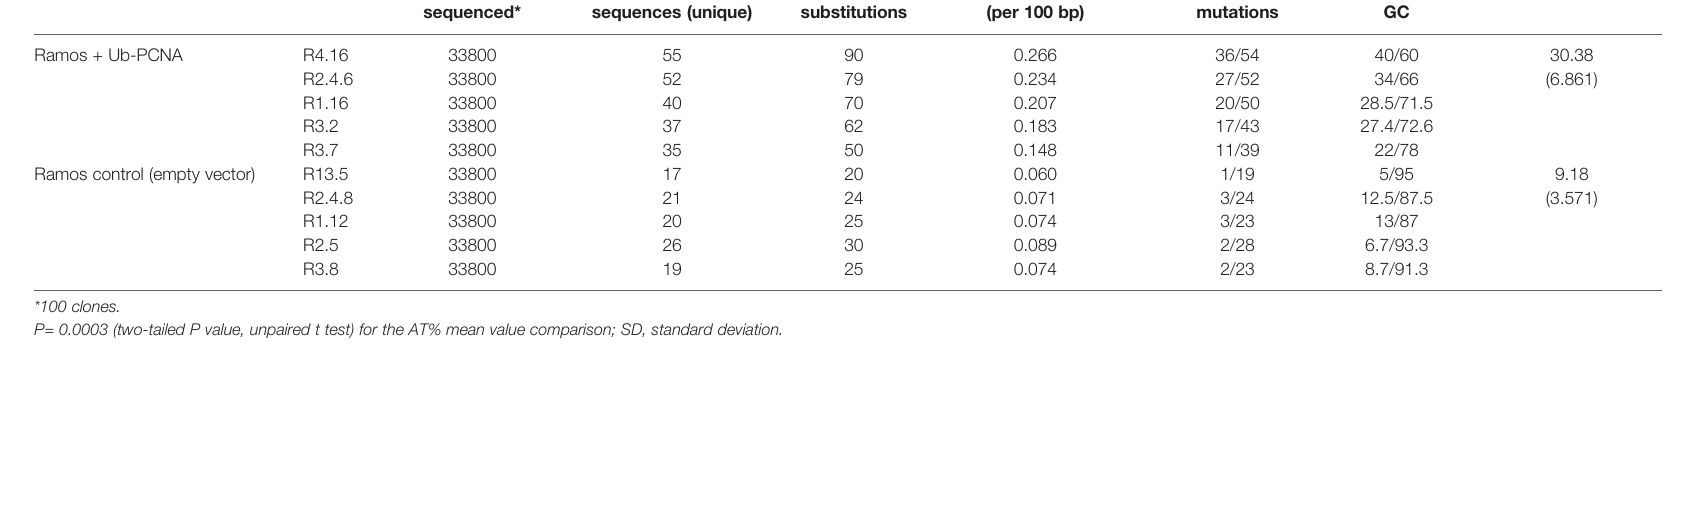
Number of Mutation frequency Number of AT/GC % AT/ AT % mean value(SD) substitutions (per 100 bp) mutations GC